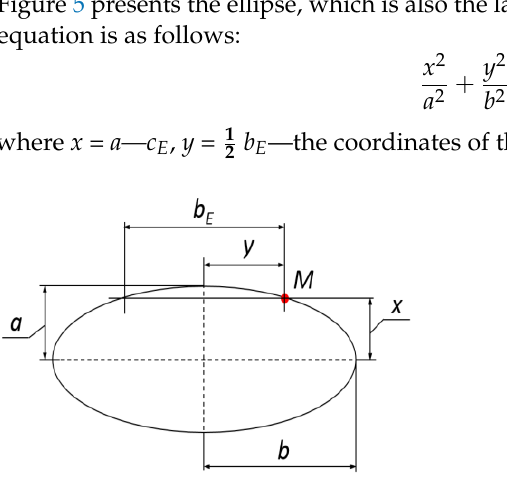
Figure 5. The largest ellipsoid cross-section with auxiliary denotations for determination of the large half-axis b value.